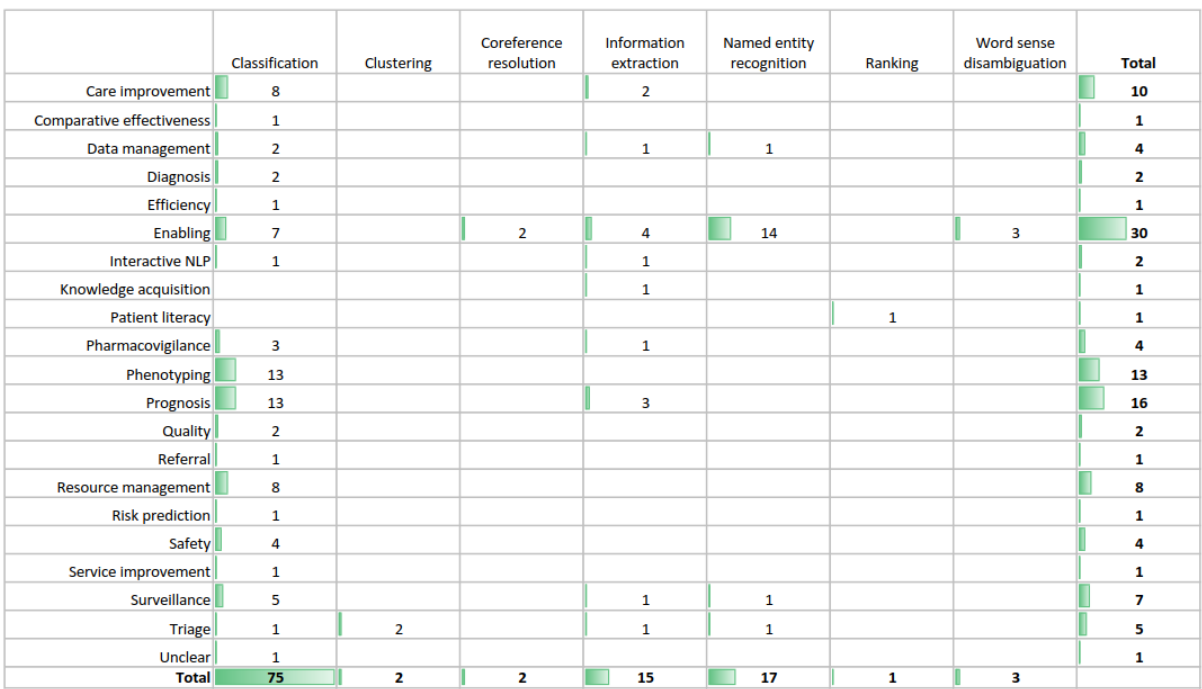
Figure 4. Clinical applications underpinned by natural language processing